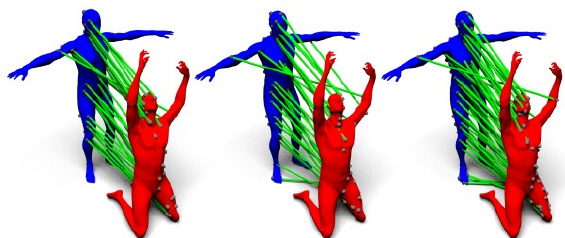
Figure 12. Heat kernel signature (HKS), wave kernel signature (WKS), and learned spectral descriptors for point matching between human models. Correspondences computed on TOSCA shapes with geodesic distance distortion below 10% of the shape diameter using the heat kernel signature, wave kernel signature, and learned spectral descriptor (from left to right) [95]. ©2014 IEEE. Reprinted, with permission, from R. Litman, and A. M. Bronstein, Learning Spectral Descriptors for Deformable